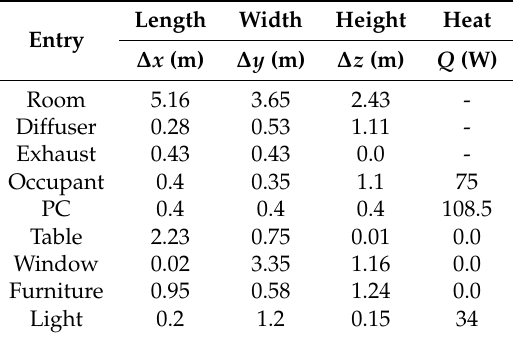
Table 1. The main parameters of the office